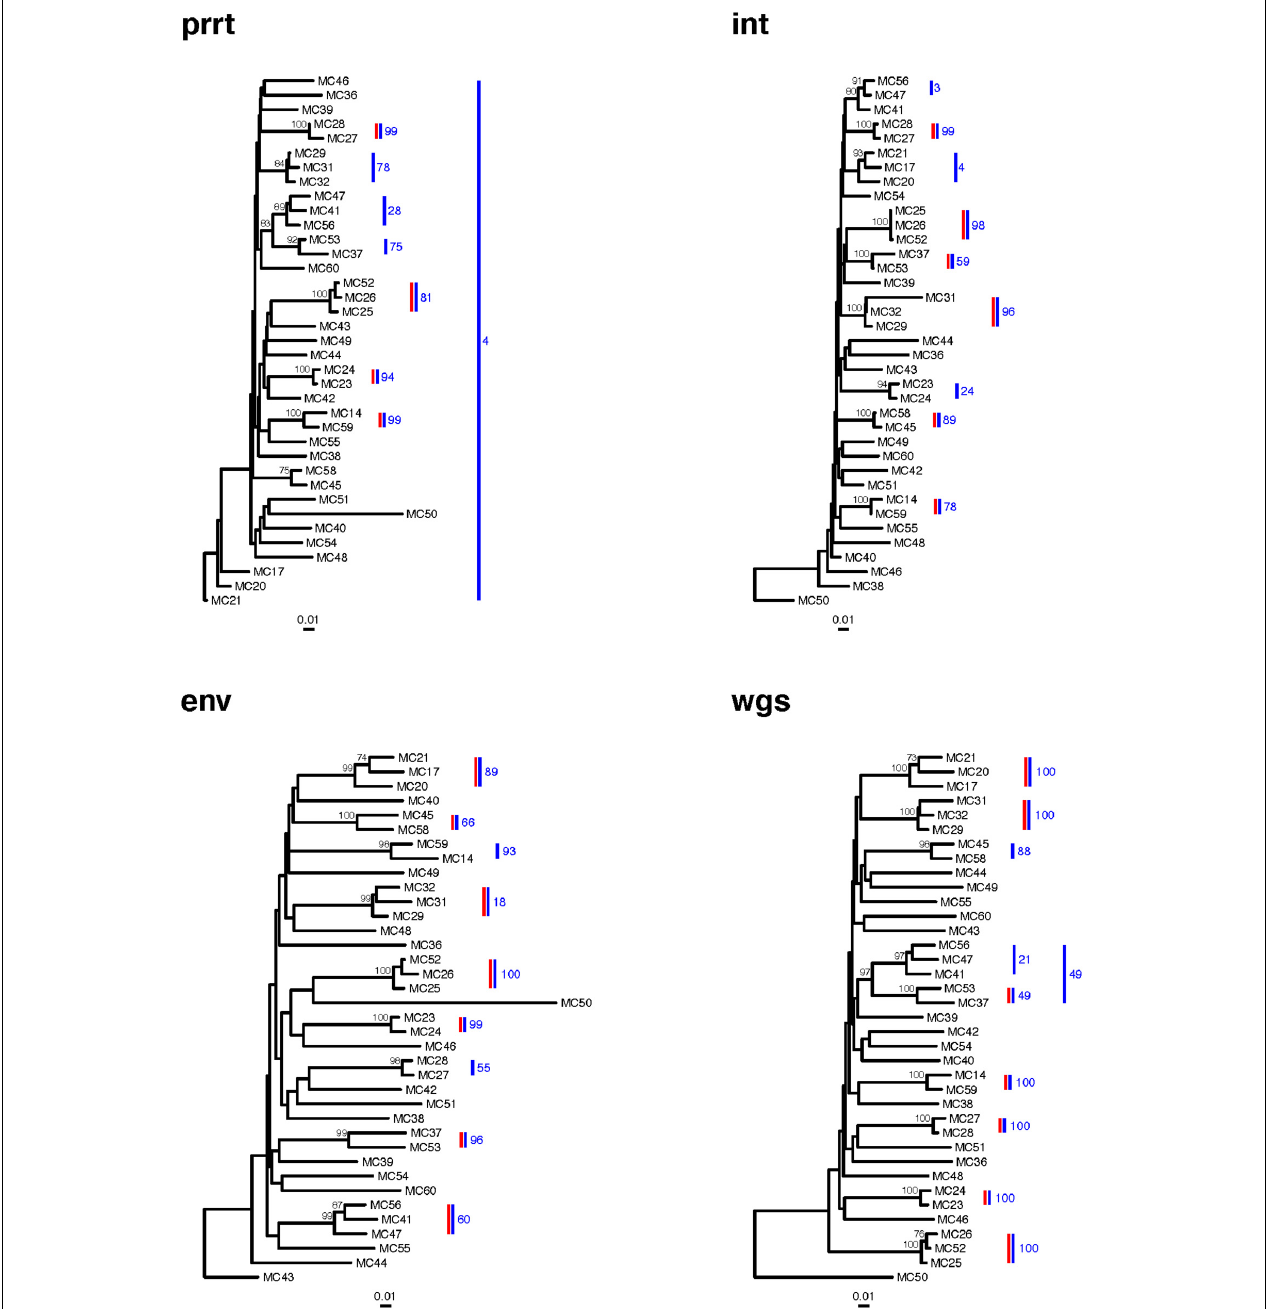
FIGURE 8 | Sanger sequence phylogenetic trees of 37 new HIV diagnoses in RI according to genomic region. The figure demonstrates clusters in phylogenetic trees from four genomic regions (prrt-protease reverse transcriptase; int-integrase; env-envelope; wgs-whole genome sequence). Clusters ( ≥ 99% bootstrap support) inferred from the phylogenies of Sanger consensus sequences (vertical red bars) differ across genomic regions. The largest number of clusters was inferred from env and wgs, and the smallest number from prrt. Profile sampling detected additional clusters (vertical blue bars) and provided a bootstrap-like measure of cluster support (annotation to blue bars). Bootstraps > 70% are shown to the left of the relevant node. Trees are rooted by an HIV-1 group O sequence, which is omitted from the